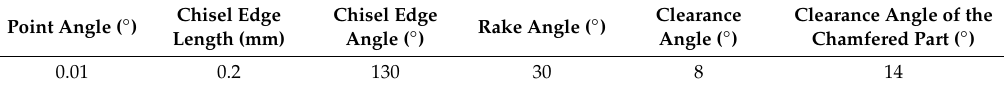
Figure 5. Modified drill. Table 3. Geometrical parameters of the drills.